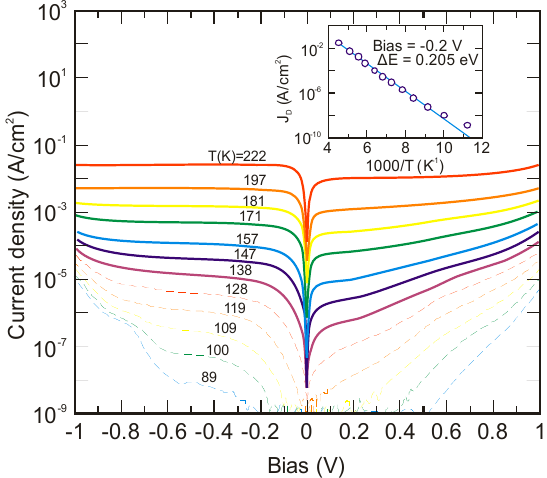
Figure 62. Dark current density versus voltage, for temperatures 89–222 K. The inset presents the dark current temperature dependence − 0.2 V (after [171]).